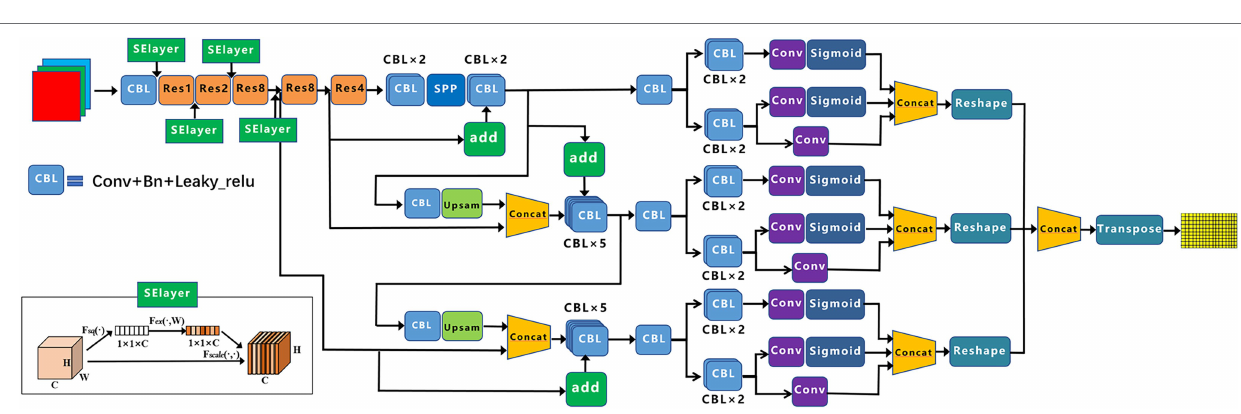
FIGURE 4 | Improved YOLOX-m framework